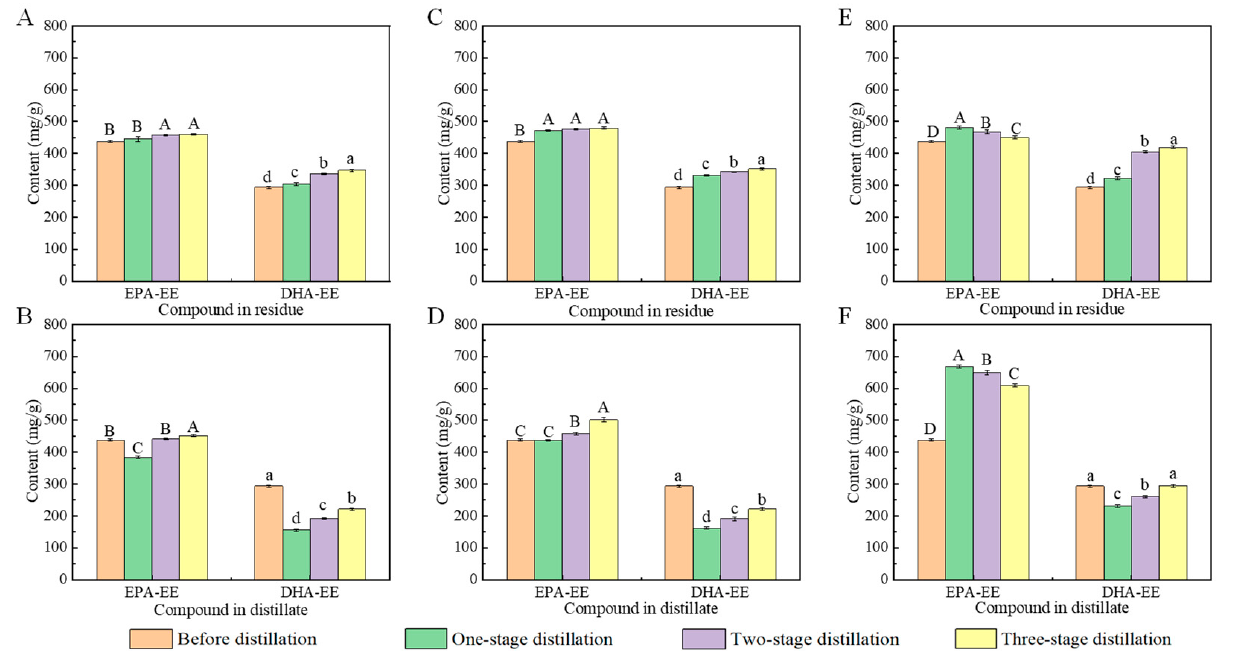
Figure 5. Effect of the number of stages in distillation on EPA-EE content and DHA-EE content in residues (( A ) 85 ◦ C; ( C ) 100 ◦ C; ( E ) 115 ◦ C) and distillates (( B ) 85 ◦ C; ( D ) 100 ◦ C; ( F ) 115 ◦ C). Values with different lowercase letters (a–d) or uppercase letters (A–D) are significantly different at p < 0.05.